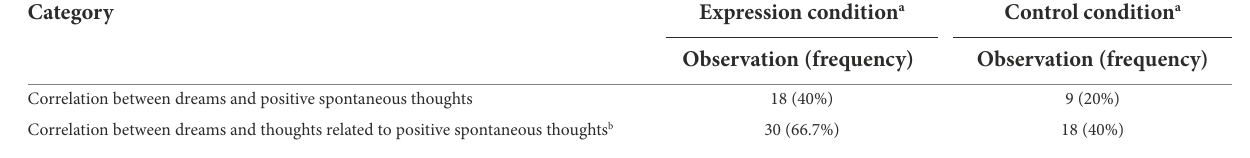
TABLE 2 The observation (percentage) for descriptive data of the